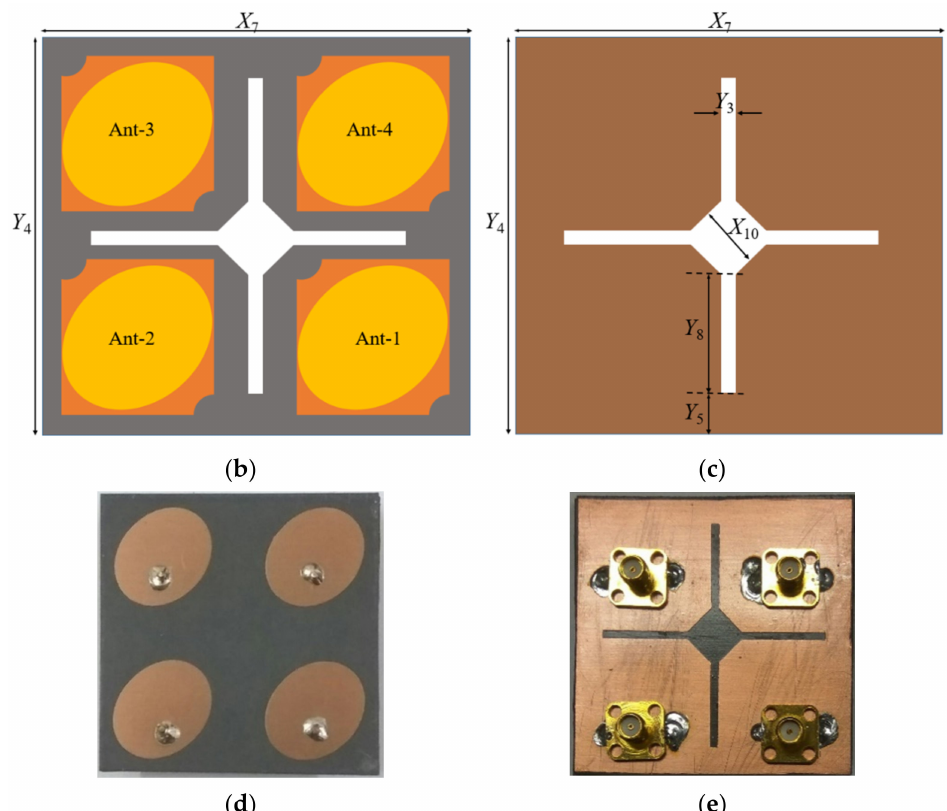
Figure 9. Geometry of the four-element stacked MIMO antenna: ( a ) side view; ( b ) top view; ( c ) ground plane; ( d ) antenna prototype (top view); ( e ) antenna prototype (bottom